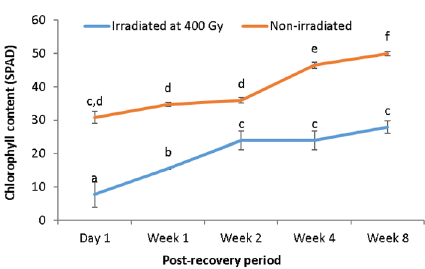
Figure 2. SPAD values of non-irradiated, and irradiated A. comosus plantlets at five different post-recovery